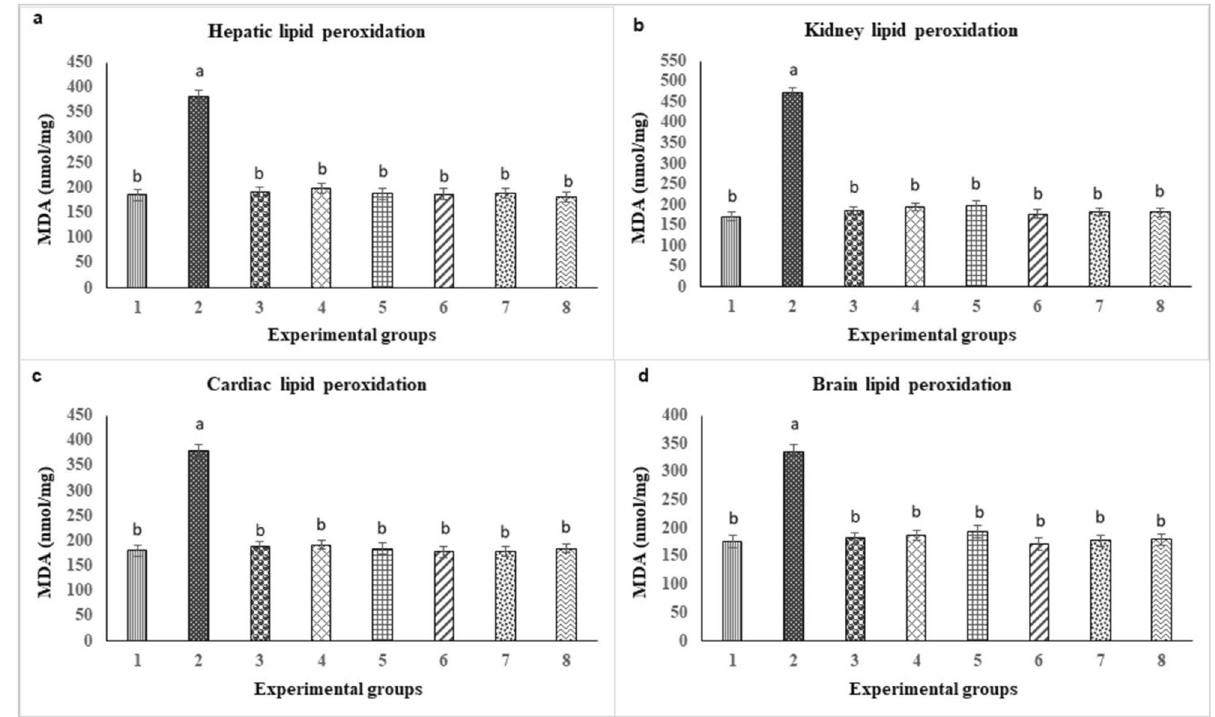
Figure 5. Effect of propolis and BV on the lipid peroxidation in (a) liver, (b) kidney, (c) heart and (d) brain. Data are expressed as mean ± SE. Means having different superscript letters within the same column are significantly different at p < 0.05.